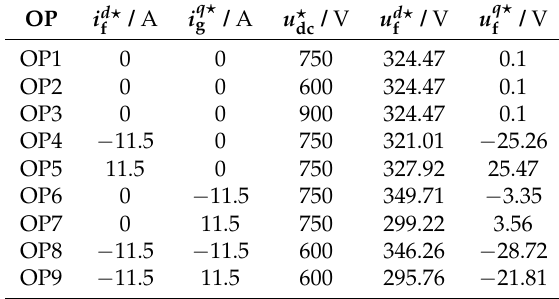
Table 4. relevant operating points for sampling frequency f s = 4kHz and weighting factor q ξ =